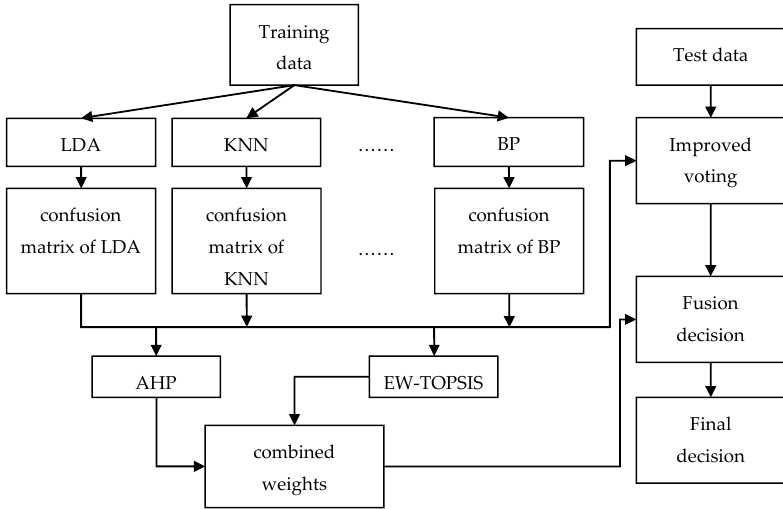
Figure 1. Decision fusion system based on combination weights and the improved voting method. AHP: analytic Hierarchy Process; BP: BP neural network; EW-TOPSIS: entropy weight-technique for order performance by similarity to ideal solution; KNN: K-nearest neighbor; LDA: linear discriminant analysis.